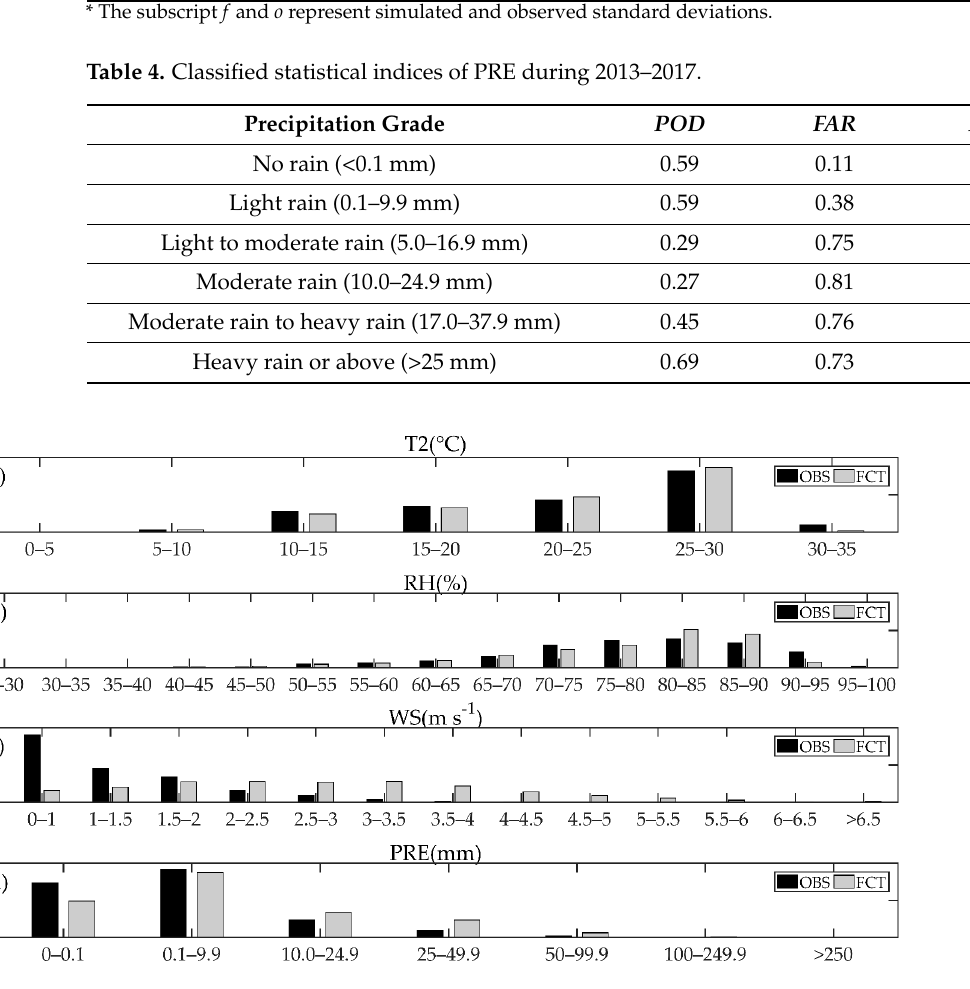
Figure 3. The probability density function (PDF) of daily averaged values for T2 ( a ), RH ( b ), WS ( c ) and PRE ( d ). OBS is observed values and FCT is simulated values.